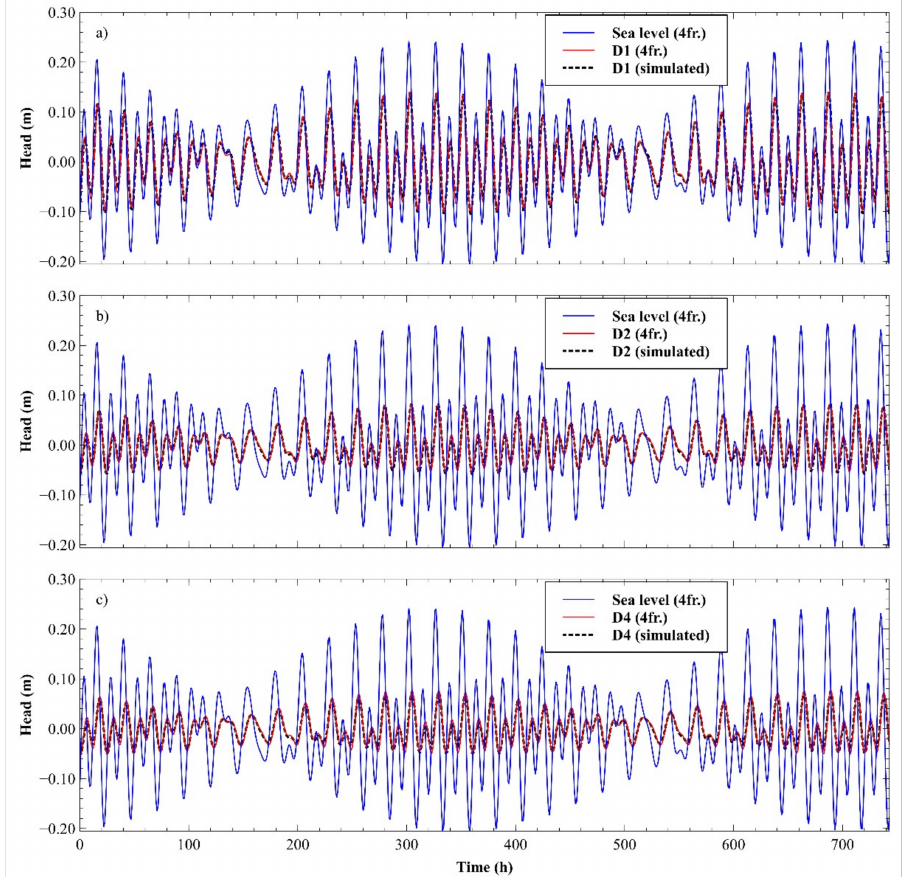
Figure 8. ( a ) Generated and four constituent tidally induced piezometric heads for the period 1 August to 31 August 2015 at D1; ( b ) generated and four constituent tidally induced piezometric heads for the period 1 August to 31 August 2015 at D2; ( c ) generated and four constituent tidally induced piezometric heads for the period 1 August to 31 August 2015 at